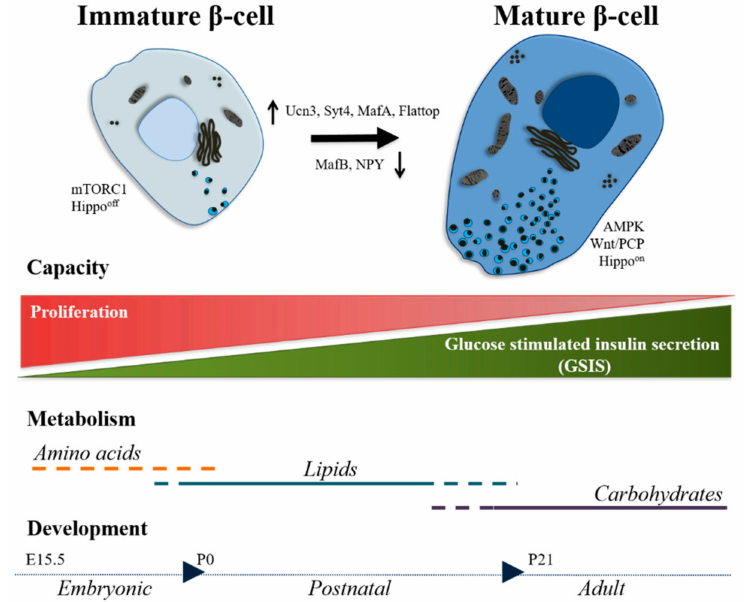
Figure 2. β -cell maturation process. Simplified representation of the complex group of events leading to the β -cell maturation in rodents. In the top part of the figure, β -cells in their immature ad mature stages, characterized by key signaling pathways. Between the two cells, the prominent TFs and markers that are di ff erentially regulated in the maturation process are shown. Below the two most significant capacities are mentioned, proliferation for immature β -cells and GSIS for mature β -cells. Following, the type of metabolisms a ff ecting the maturation stages are mentioned. At the bottom, the timeline of the β -cell maturation process is